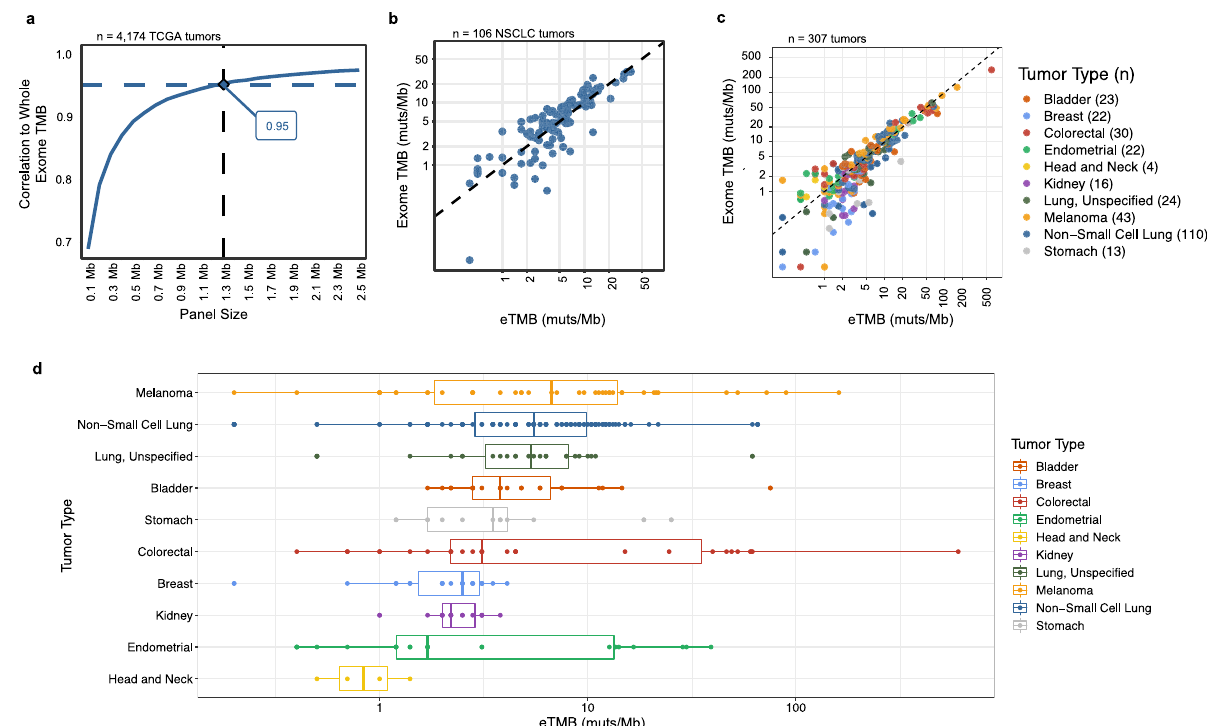
Fig. 3 In silico and experimental comparison of the targeted panel and whole-exome TMB performance. a The correlation of in silico predicted tumor mutation burden (TMB) for panels of different size (100 kilobases to 2.5 megabases, Mb) to observed whole-exome sequencing (WES) TMB for samples in The Cancer Genome Atlas (TCGA) suggested that panels of >1 Mb provide accurate TMB measurements. TMB analyses were performed in a metastatic population weighted according to the relative frequency of late-stage cases per year. b Comparison of the elio-predicted exome TMB (eTMB) using elio tissue complete and WES of tumor and matched-normal samples in a cohort of 106 non-small cell lung cancer (NSCLC) FFPE and cell-line samples resulted in high concordance in a cross-validated analysis (Pearson correlation = 0.909, P < 0.0001 and Spearman rho = 0.855, P < 0.0001). c Evaluation of eTMB in an independent cohort of 307 FFPE-derived pan tumor samples demonstrated high correlation to WES (Pearson correlation = 0.949, P < 0.0001 and Spearman rho = 0.870, P < 0.0001). d Distribution of eTMB scores in the independent cohort of 307 FFPE-derived tumors by tumor type, with the number of each tumor type captured in ( c ). The boxes represent the 25th and 75th percentile (interquartile range, IQR), while the median is re fl ected by the middle line of the box. The whiskers represent 1.5*IQR, with outliers plotted as points not connected to the whiskers. The Pearson and Spearman correlation coef fi cients were calculated using a two-sided test, and no adjustments were made for multiple comparisons. Source data are provided as a Source Data fi le. Muts/Mb mutations per